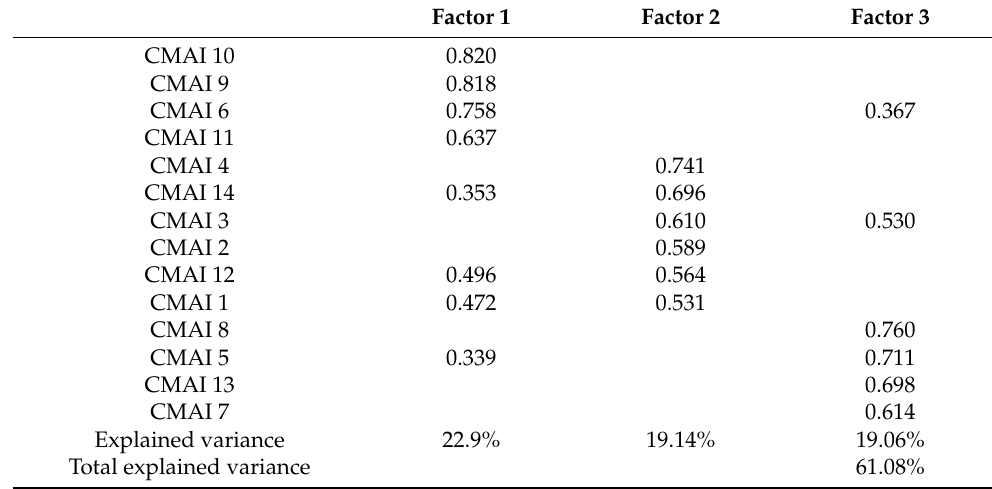
Table 4. Factor structure of the C-CMAI-SF using exploratory factor analysis.